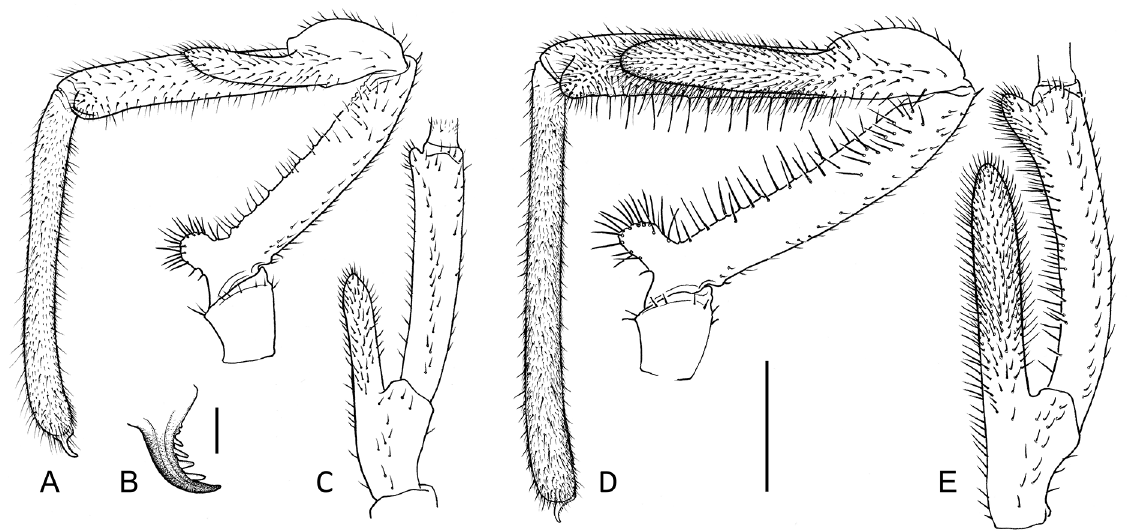
Fig. 19. Dicranopalpus pyrenaeus Dresco, 1948. Right pedipalp. A – C . Male. D – E . Female. A , D . Median view. B . Claw. C , E . Dorsal view of patella and tibia. Scale bars: A, C–D = 0.5 mm; B = 50